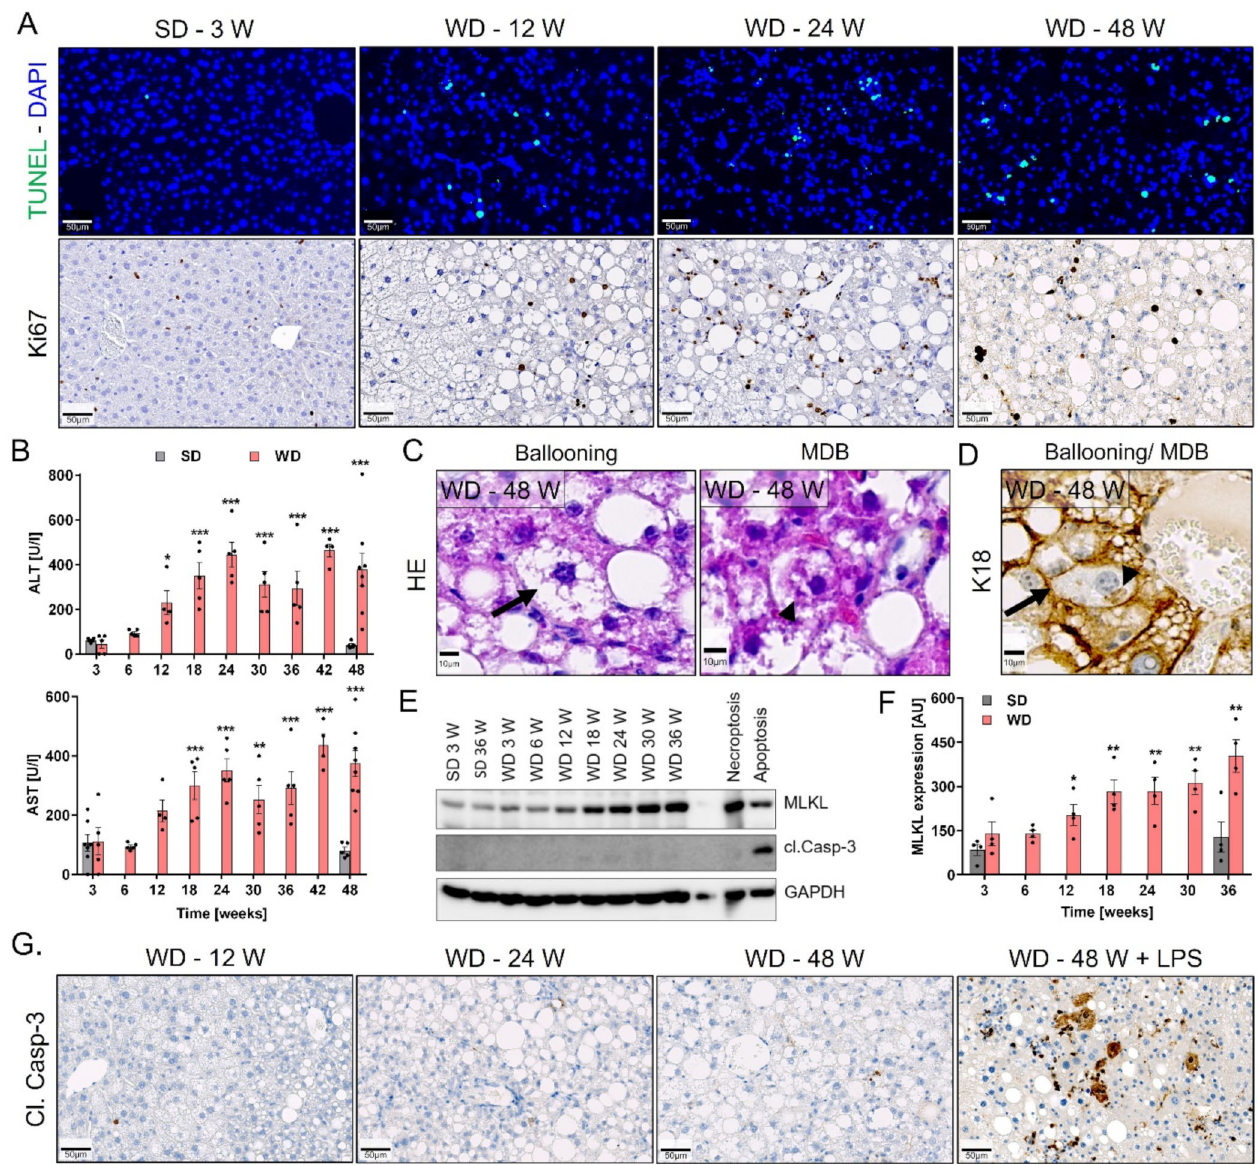
Figure 4. Cell death during NASH progression. ( A ) TUNEL and Ki67 staining in liver sections of SD- (3 week) and WD-fed mice. ( B ) Liver enzyme activities (ALT and AST) in the heart blood of mice fed a SD or WD. ( C ) Examples of ballooning (arrows) and Mallory–Denk bodies (arrowhead, MDB) in H&E-stained liver tissue sections. ( D ) Visualization of ballooning and MDB by K18 immunostaining. ( E , F ) Representative image of Western blot with accompanying quantification of the necroptosis marker MLKL and the apoptosis marker cleaved caspase-3 in livers of SD- and WD-fed mice over time. ( G ) Cleaved caspase3 immunostaining at different time intervals after WD feeding; LPS: lipopolysaccharide. Data in B and F are means and standard error of 4–5 mice per time point. *: p < 0.05; **: p < 0.01; ***: p < 0.001 compared to SD week 3, Dunnett’s multiple comparisons ( B ) or unpaired t (F) tests; data of individual mice are illustrated by dots; SD: standard diet; WD: Western diet. Scale bars: 50 µ m ( A , G ) and 10 µ m ( C , D